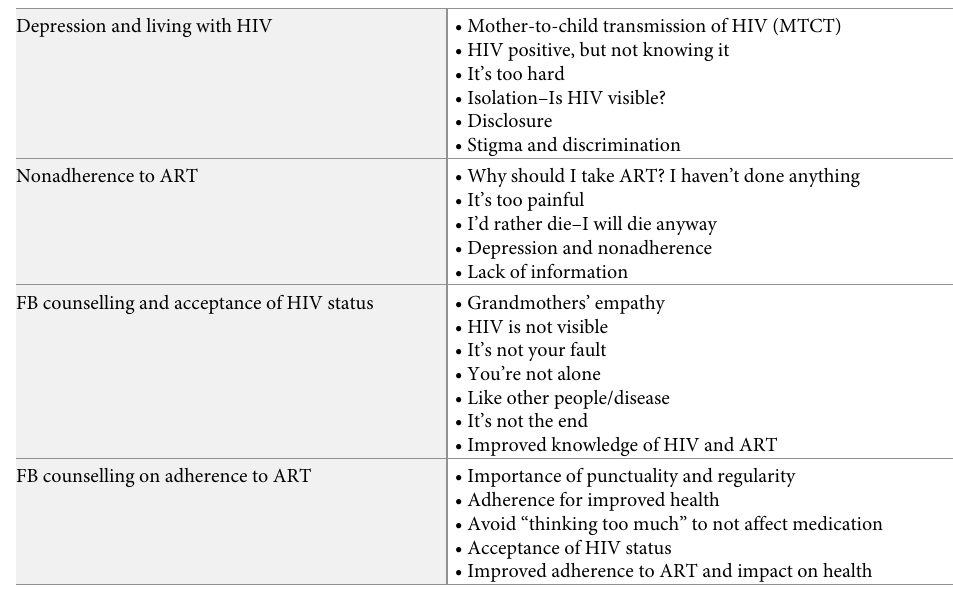
Table 2. Thematic areas identified from the